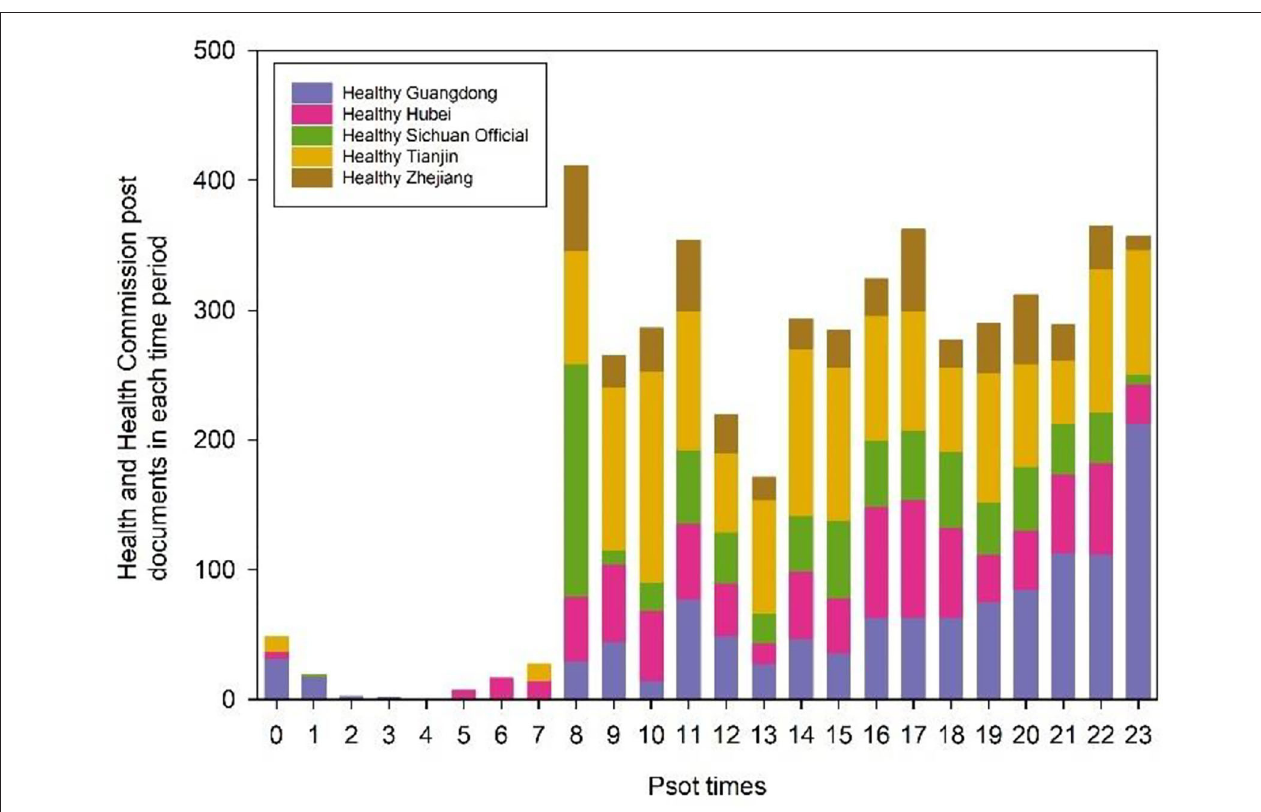
FIGURE 4 | Trend of the number of tweets of different WeChat official accounts in each time period.